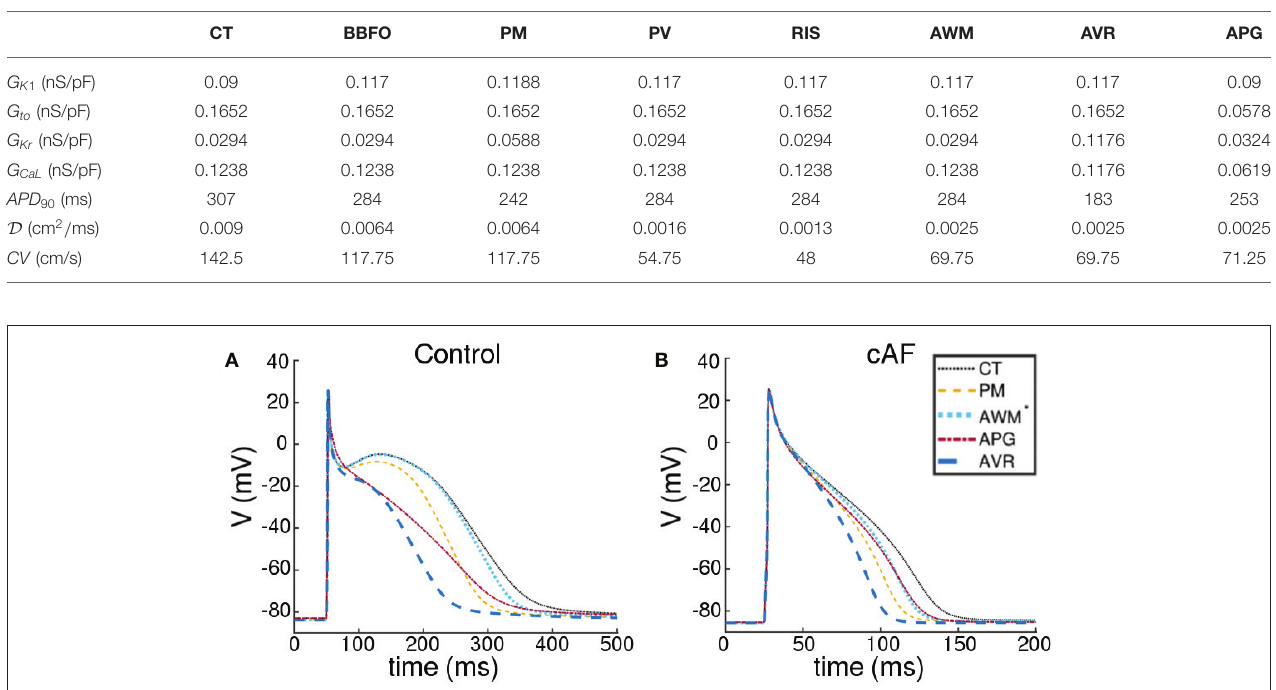
TABLE 1 | Region-specific adjustments to the CRN model, with corresponding APD 90 and CV at 37 ◦ C , in the control atria.